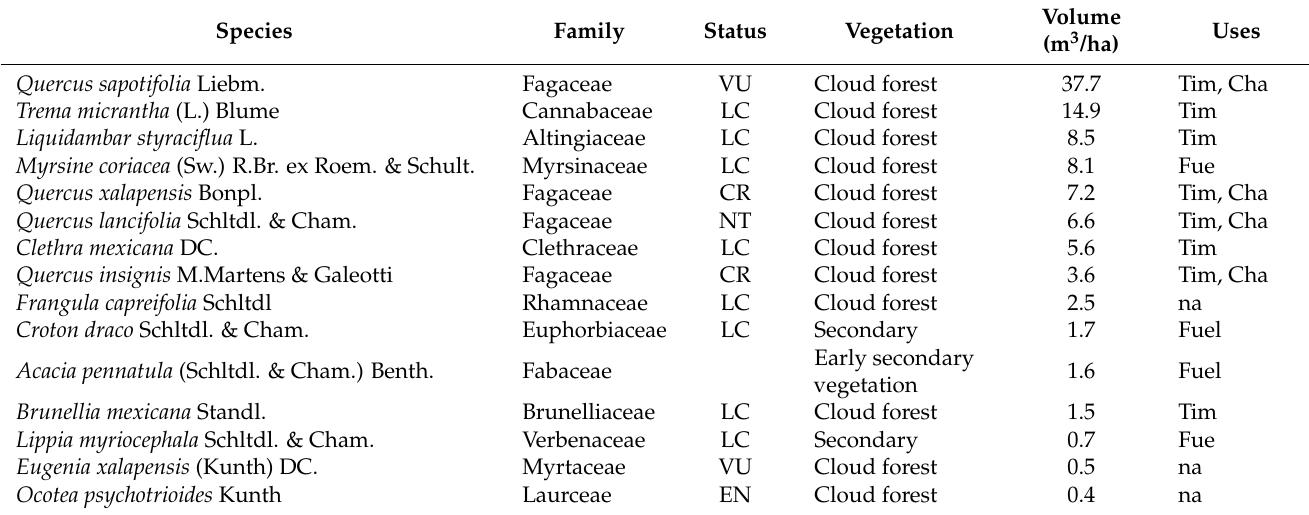
Table 2. Tree species in 20 year-old secondary cloud forest, Veracruz, Mexico, in decreasing or- der of volume (includes remnant old trees). Conservation status: CR = Critically Endangered, EN = Endangered, VU = Vulnerable, NT = Near Threatened and LC = Least Concern [45]. Uses: Cha = charcoal, Fue = fuelwood, Fruit = fruit edible, Tim = timber, Timb int = timber for interiors, na = not available